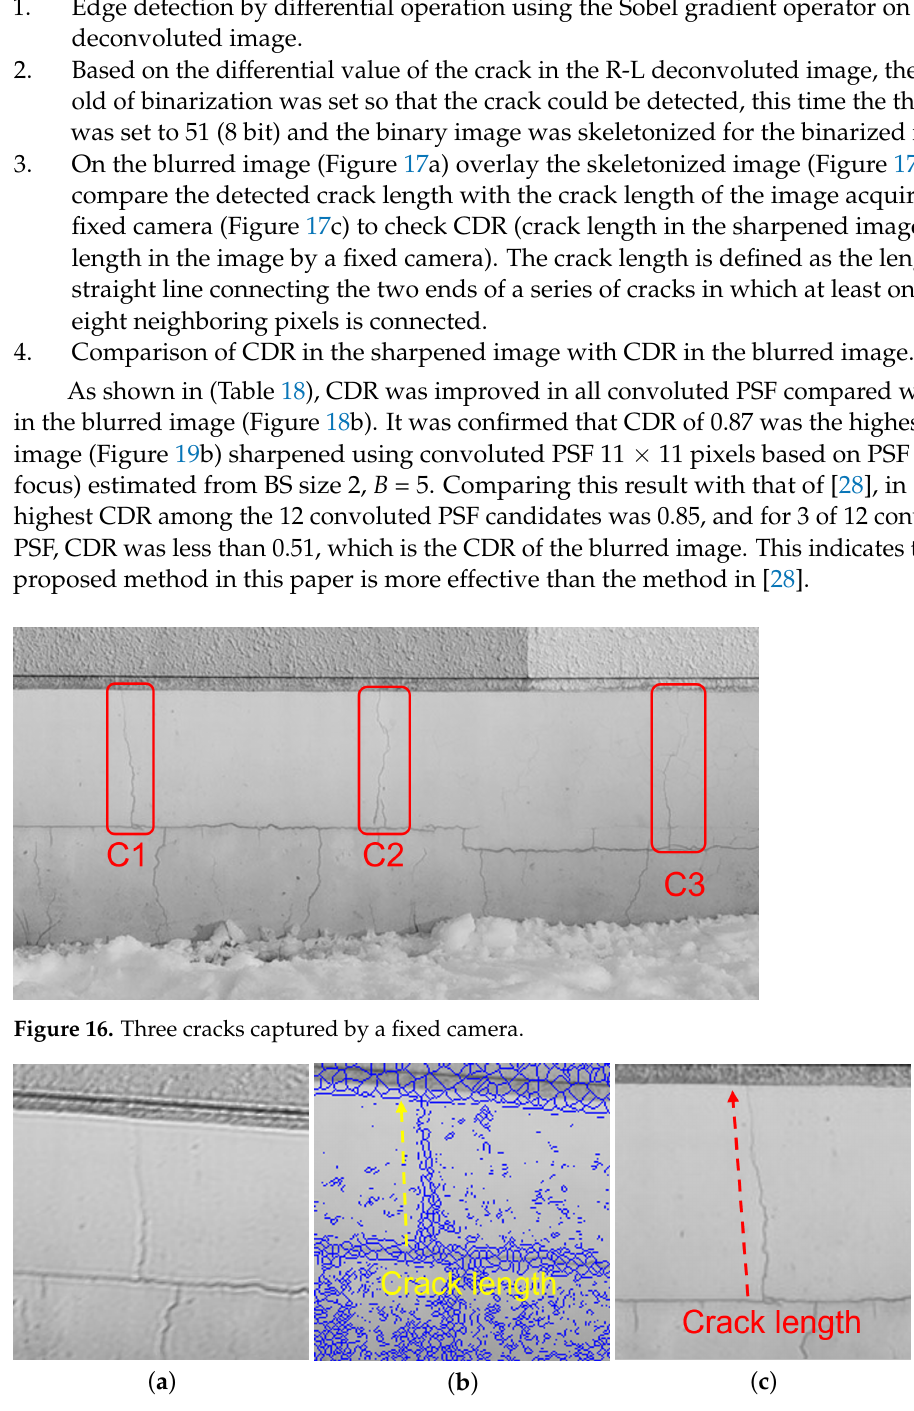
Figure 17. Crack image and crack length. ( a ) Sharpened image by deconvolution applying to motion blurred crack image; ( b ) Tracked crack (blue) superimposed on the image ( a ); ( c ) Crack image captured by a fixed